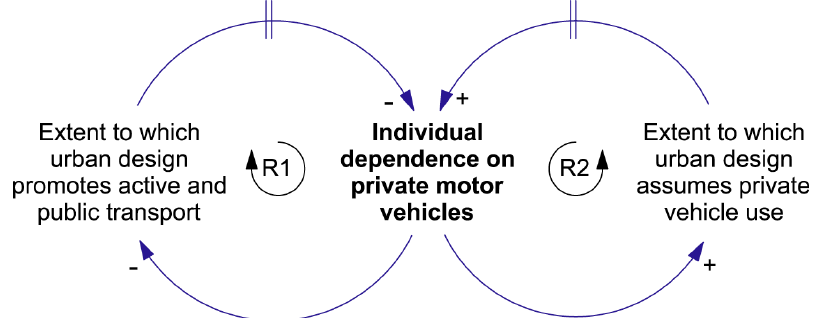
Figure 9. The Adaptive Challenge. This causal loop diagram instantiates the feedback structure of the Success to the Successful archetype. There are two reinforcing loops, R1 and R2 , that work together to affect the extent to which individuals depend on cars. This feedback system has contributed to the growth of car dependence in modern cities. The challenge is to reverse this